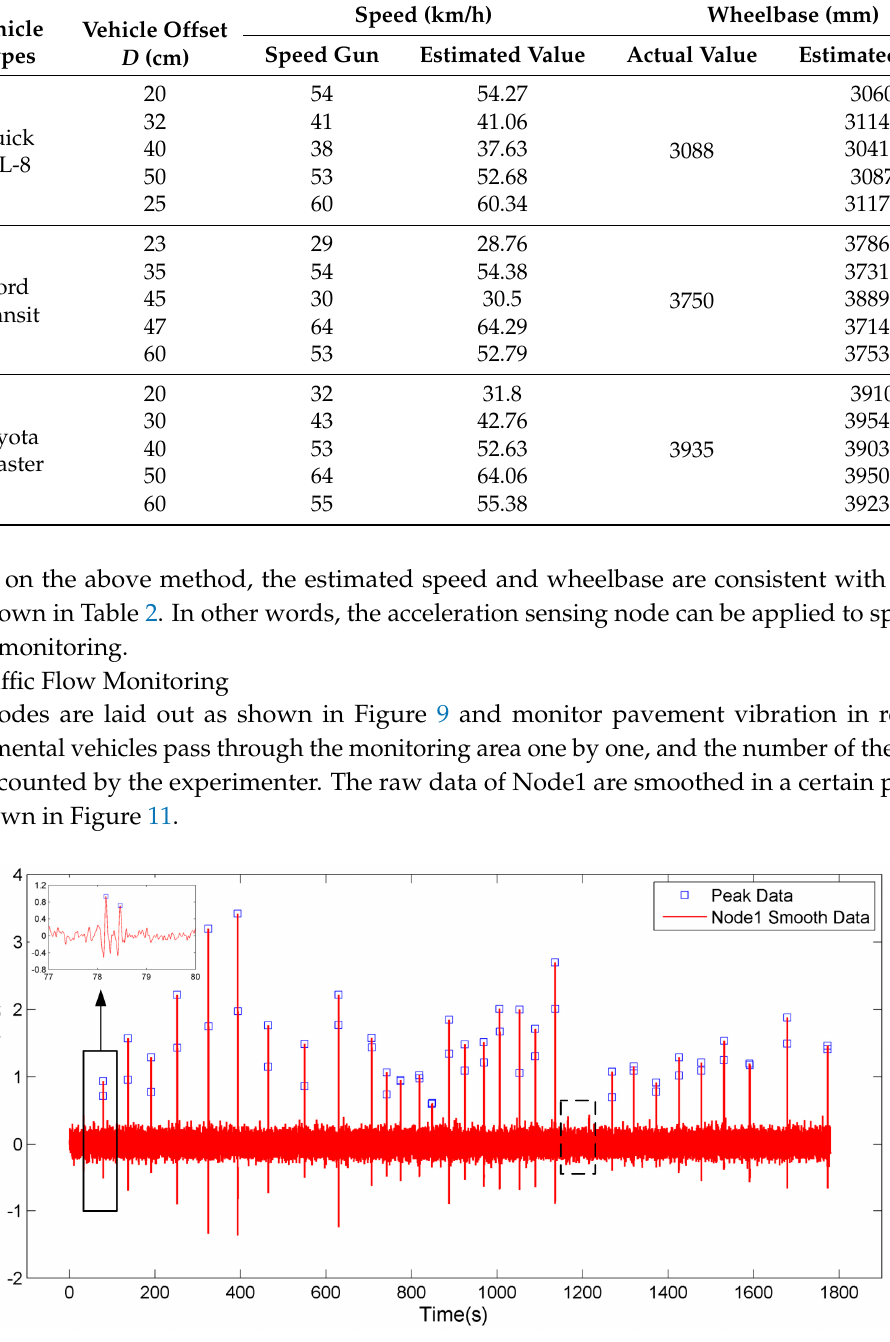
Figure 11. The smoothed data in a certain period of time.